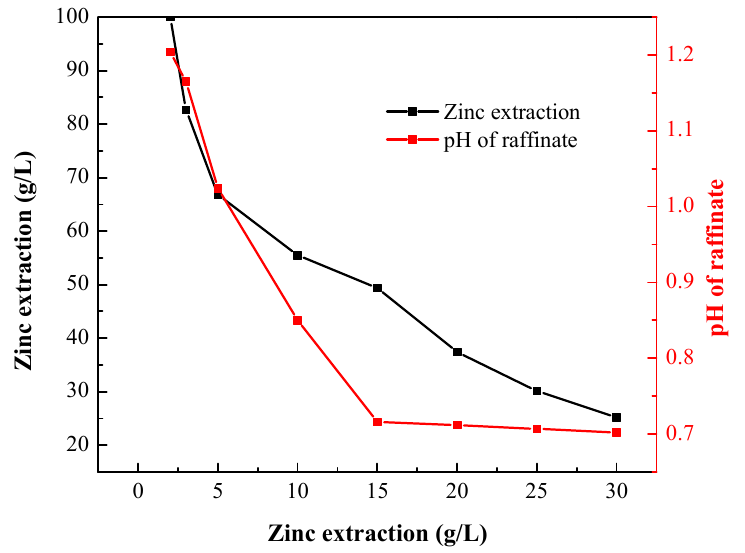
Figure 1. The effect of zinc concentration on zinc extraction. Conditions: initial pH 3.0, D2EHPA concentration 20%, O/A ratio 50:50, stirring speed 1000 rpm, and time 10 min. Table 1. Effect of alkali dosage on zinc extraction from a zinc concentration of 30 g/L solution. Alkali Dosage (g/L)